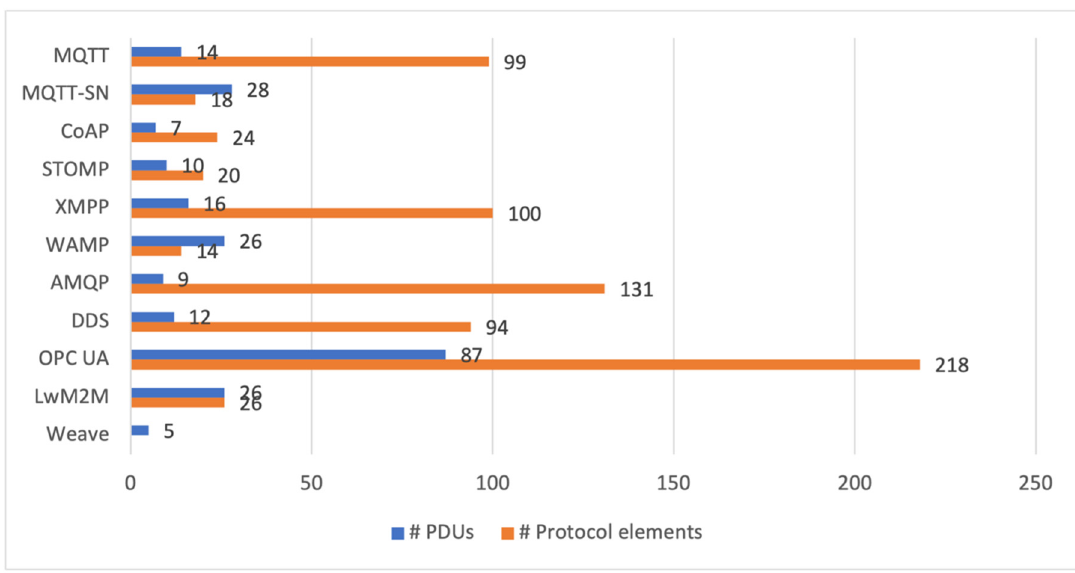
Figure 3. Complexity of the protocols (number of defined protocol elements).